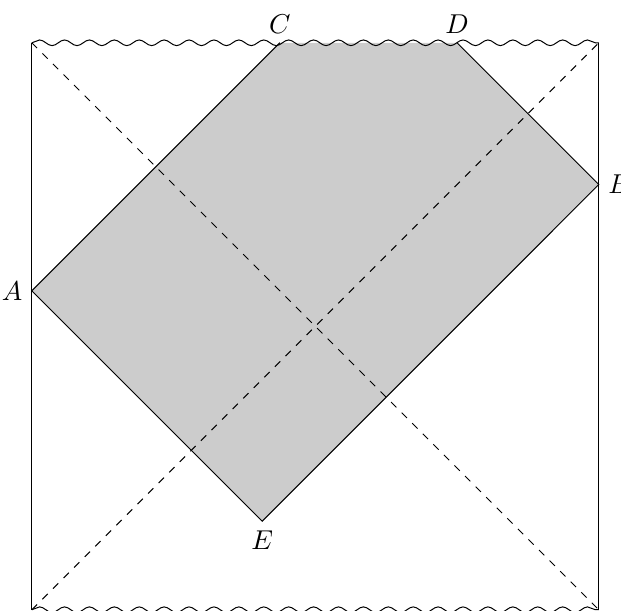
Figure 1. The shaded part of the Penrose diagram shows a WDW patch of a Cauchy surface that intersects r = 1 at A and B. The past and future horizon are represented by dashed lines, while the past and future singularity are represented by wave